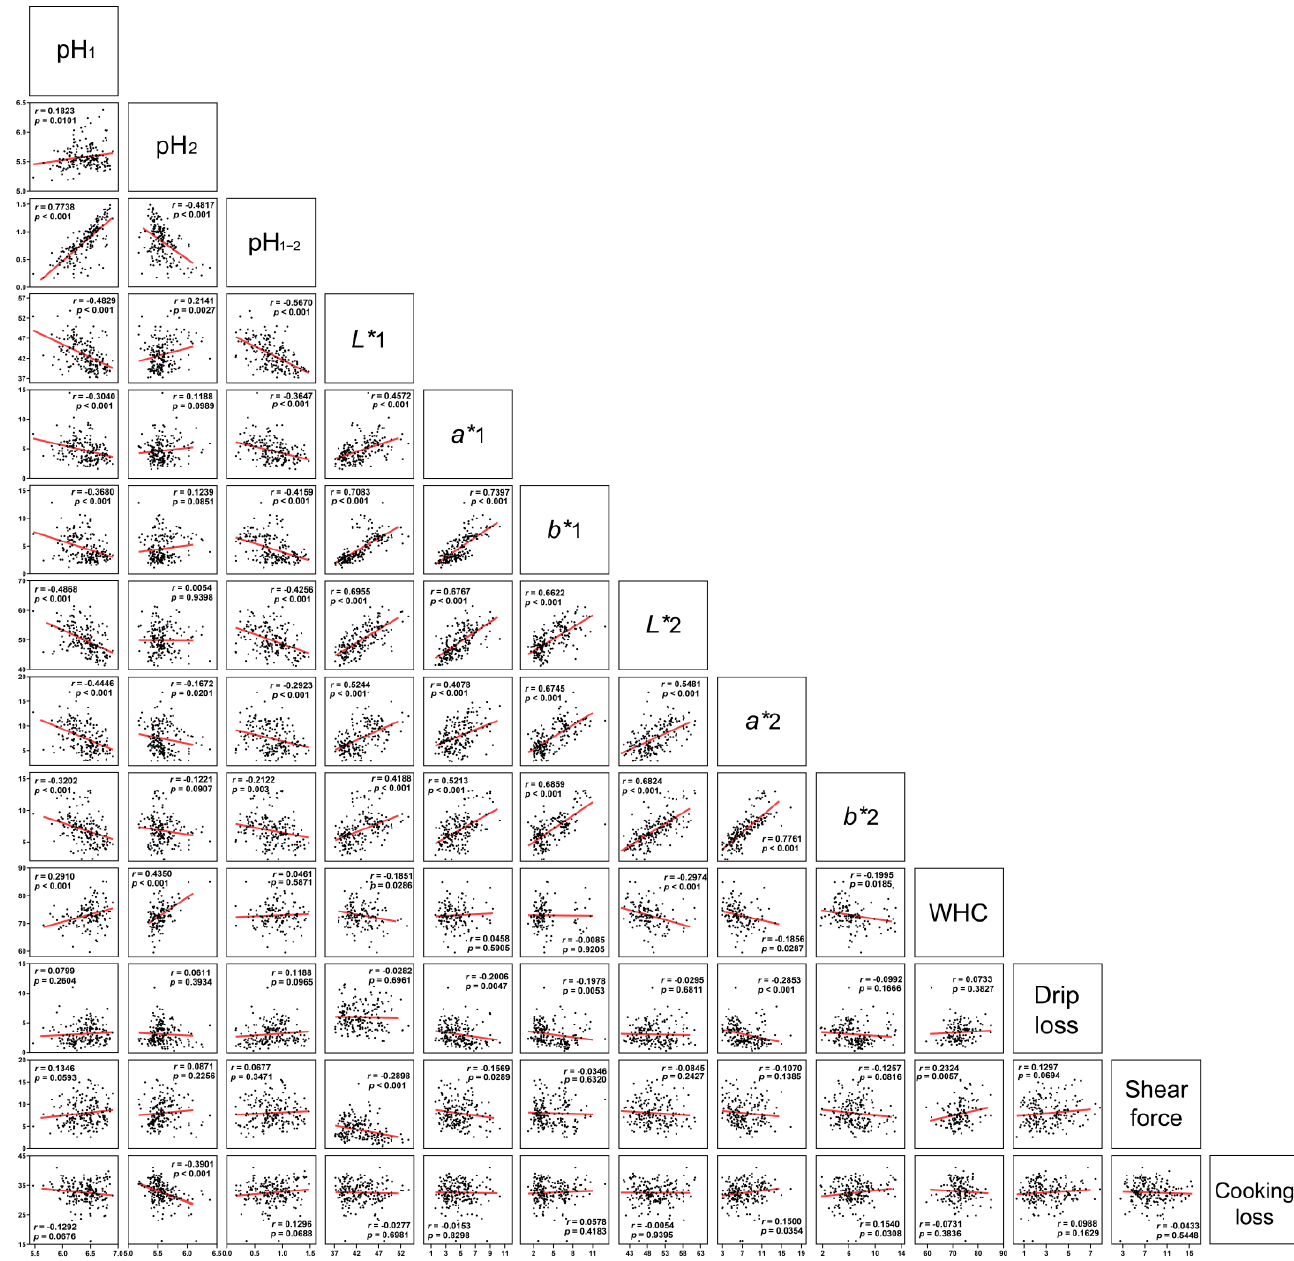
Figure 1. Pearson’s correlation coefficients for pork meat quality traits. pH 1 , L* 1, a* 1, and b* 1 values were measured 45 min postmortem; pH 2 , L* 2, a* 2, and b* 2 values were measured 24 h postmortem; pH 1-2 corresponded to the difference between pH 1 and pH 2 values. WHC: water holding capacity. N = 73 – 202. Pearson correlation coefficients ( r ) and p values were determined by Pearson correlation analysis. Red lines indicate the trend line.